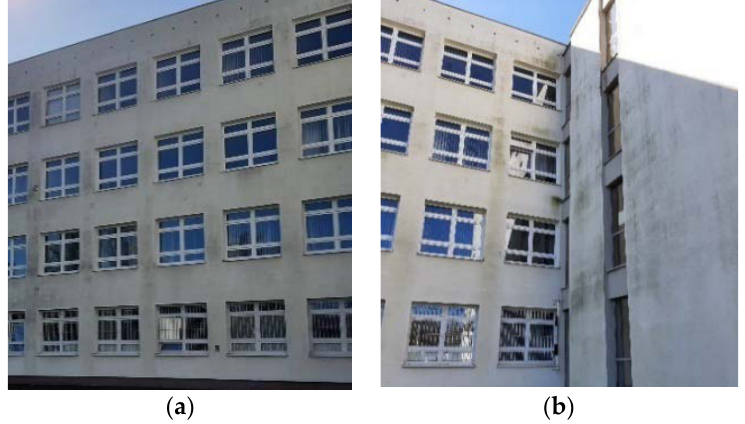
Figure 2. Changes on the exterior wall finish surface (author’s archives) ( a ) Uniformly distributed growth on the exterior wall finish, ( b ) Local contamination concentrations